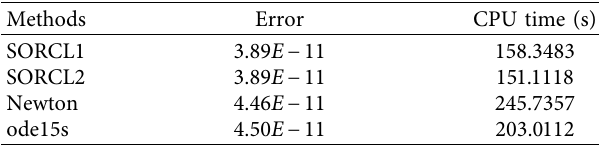
Table 8: Tolerance level at 10 − 11 (SIR model).